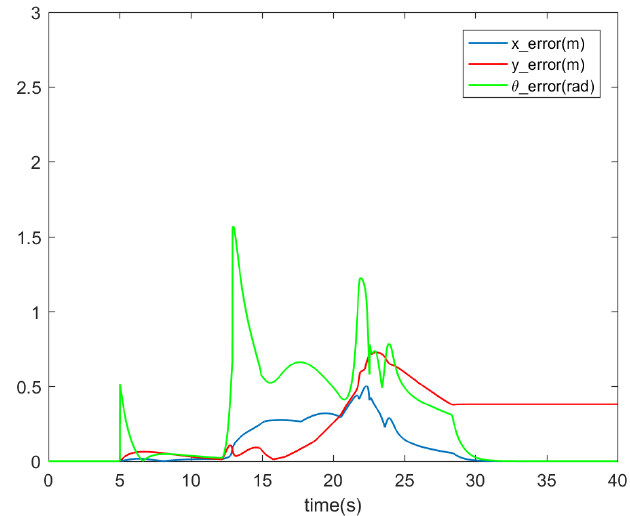
Figure 9. The formation tracking errors for robots in formation with C1.